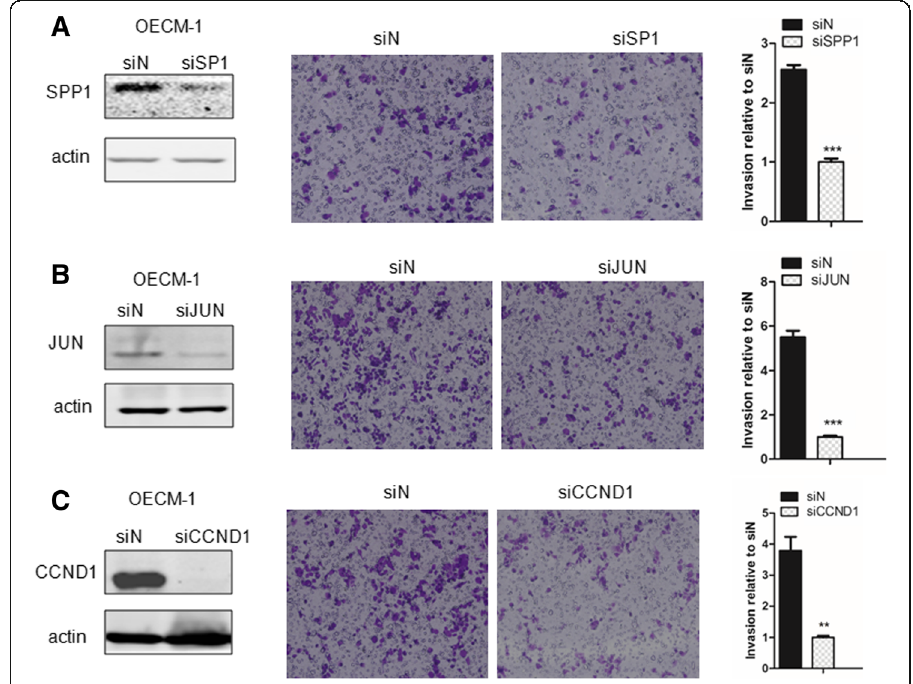
Fig. 3 CCND1, JUN and SPP1 are involved in oral cancer cell invasion. a Human oral cancer cell line OECM-1 was transfected with SPP1 siRNA, SPP1 protein expression was examined through western blot, and alteration of cell invasion ability was examined and quantified as a histogram. b Human oral cancer cell line OECM-1 was transfected with JUN siRNA, JUN protein expression was examined through western blot, and alteration of cell invasion ability was examined and quantified as a histogram. c Human oral cancer cell line OECM-1 was transfected with CCND1 siRNA, CCND1 protein expression was examined through western blot, and alteration of cell invasion ability was examined and quantified as a